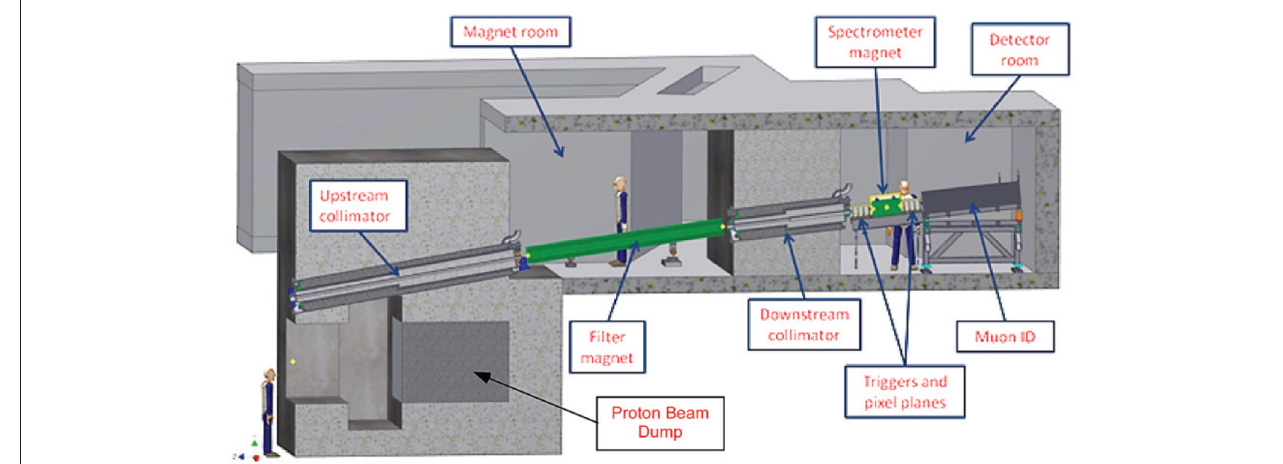
FIGURE 9 | Schematic of the downstream extinction monitor. From Bartoszek et al. [8].